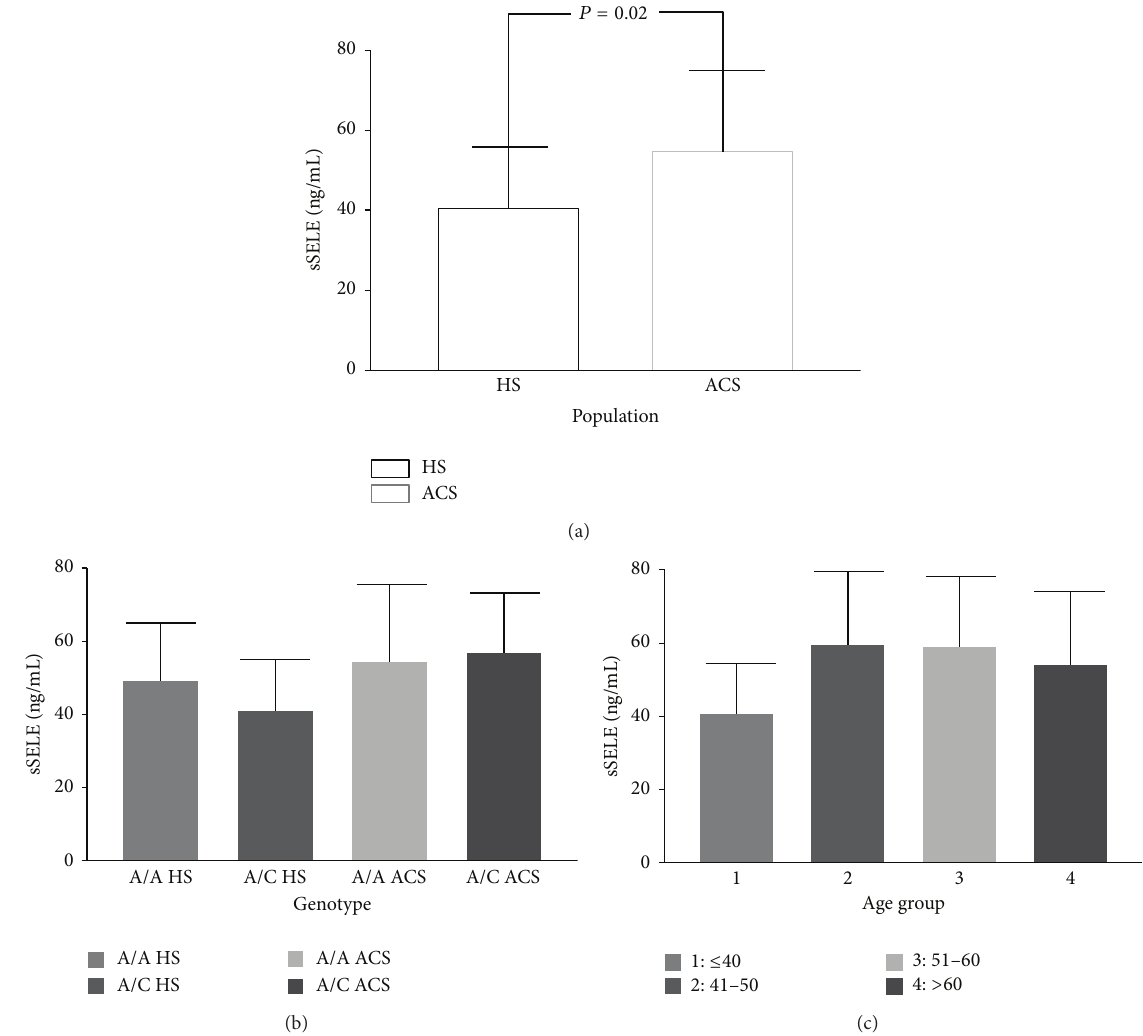
Figure 2: Serum levels comparison of sE-selectin. (a) Comparison of sE-selectin levels in serum of ACS patients ( X = 54.58 ng/mL; SD = 20.56) and HS ( X = 40.41 ng/mL; SD = 15.58), (b) comparison of sE-Selectin levels in serum of ACS patients and HS according genotype of the rs5361 (561A > C) polymorphism: ACS patients AA ( X = 54.19 ng/mL; SD = 21.29); AC ( X = 56.73 ng/mL; SD = 16.27); HS AA ( X = 49.13 ng/mL; SD=15.60); AC ( X = 41.03ng/mL; SD = 13.82), (c) comparison of sE-selectin levels in serum of HS by age range (1) X = 40.58 ng/mL; SD = 13.93; (2) X = 59.36 ng/mL; SD = 20.30; (3) X = 58.96 ng/mL; SD = 19.30; (4) X = 54.05 ng/mL; SD = 20.14. Mean ± standard deviation is shown in graphic representation. Only significant differences are highlighted. ACS: acute coronary syndrome; HS: healthy subjects; sSELE: soluble E-selectin levels. 𝑃 : Mann-Whitney U